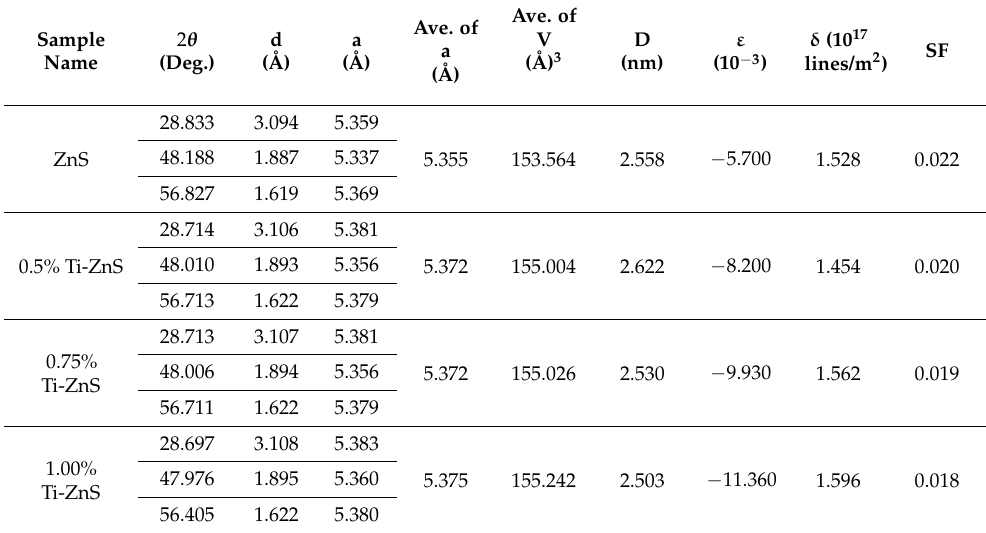
Table 1. Lattice parameters, d spacing, average unit cell volume (V), average crystallite size (D), micro strain (ε), dislocation density (δ) , and stacking Fault (SF).